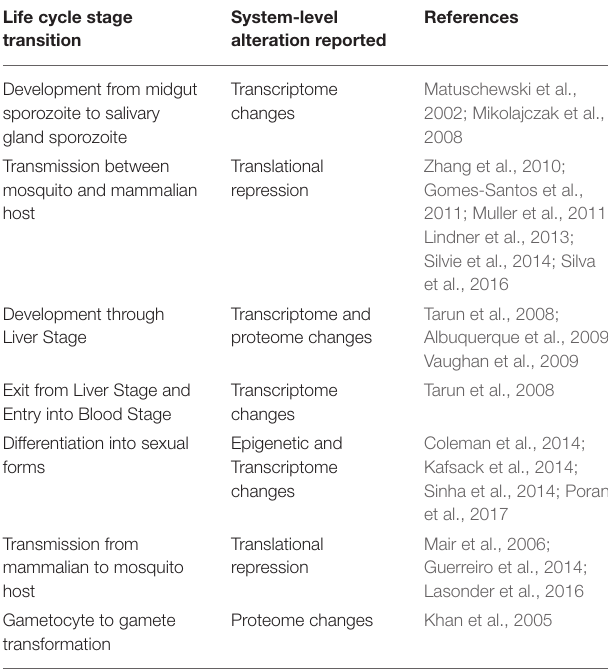
TABLE 1 | Stage transitions in the Plasmodium life